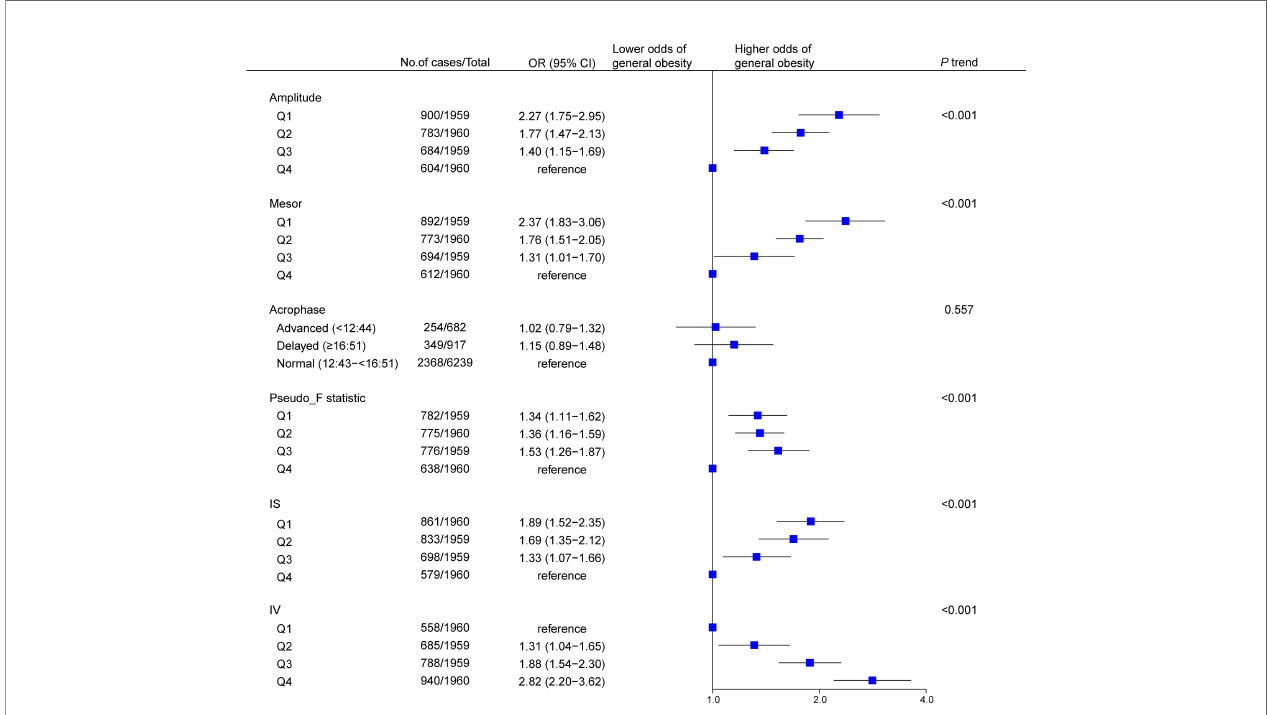
FIGURE 2 | Association between rest-activity rhythm parameters and general obesity among US adults (n=7838). Odds ratios (datapoints) and 95% con fi dence interval (error bars) are presented. CI, con fi dence interval; IS, interdaily stability; IV, intradaily variability; OR, odds ratio.